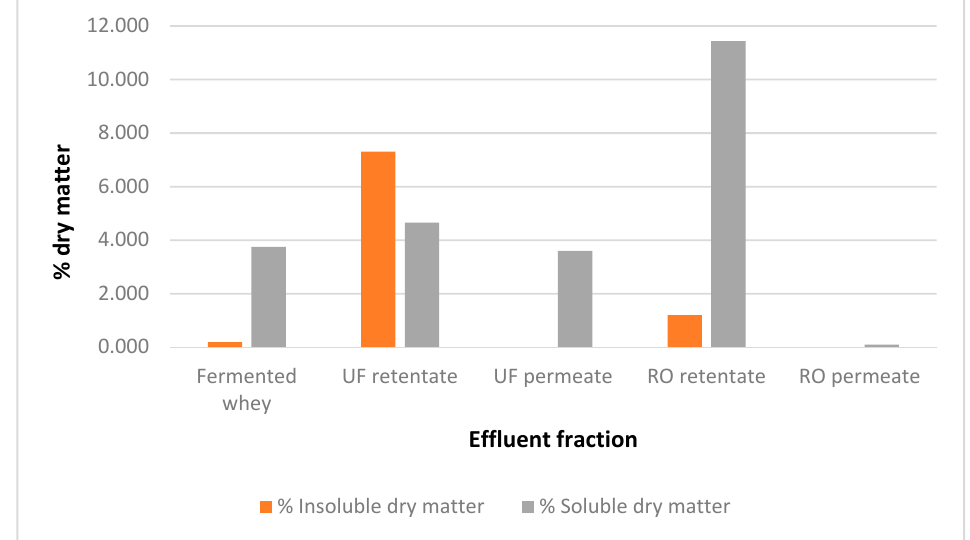
Figure 4. Percentages of dry matter (insoluble and soluble) in different fractions of the tested whey.